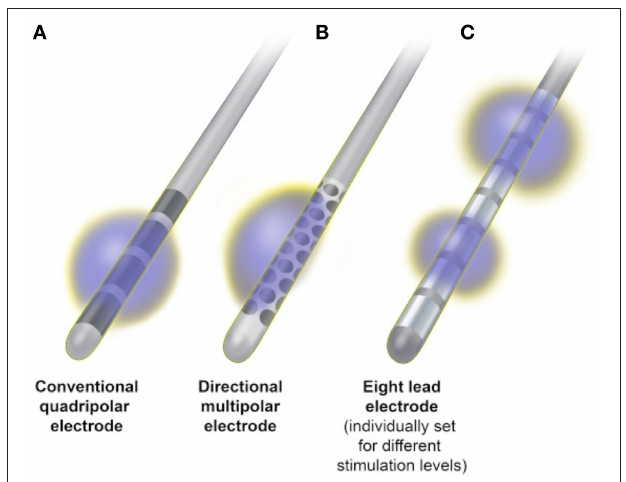
FIGURE 3 | Deep brain stimulation electrode configurations. (A) Conventional quadripolar electrode producing a spherical electrical field that may spread outside the target area, causing side effects. (B) Multipolar 32 contact electrode that allows directional steering of the field, reducing the potential for stimulation side effects. (C) Eight contact electrode with multiple independent current control (MICC), enabling the allocation of completely different stimulation parameters independently to each electrode